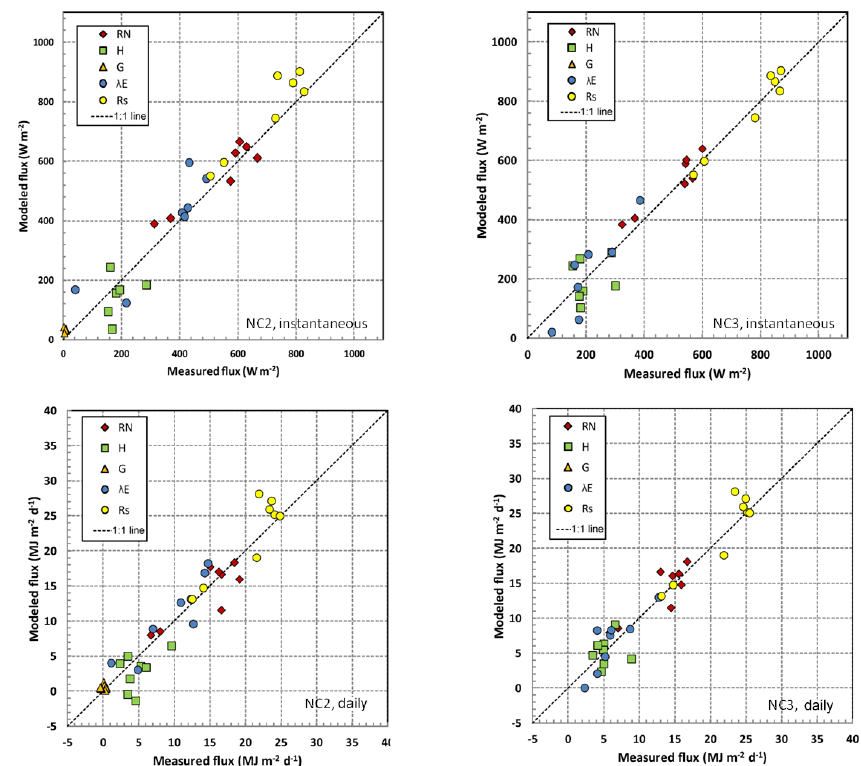
Figure 7. Scatterplot of modeled and measured instantaneous (top row panels) and daily surface fluxes (bottom row panels) on Landsat overpass dates for NC2 (left column panels) and NC3 (right column panels) flux tower